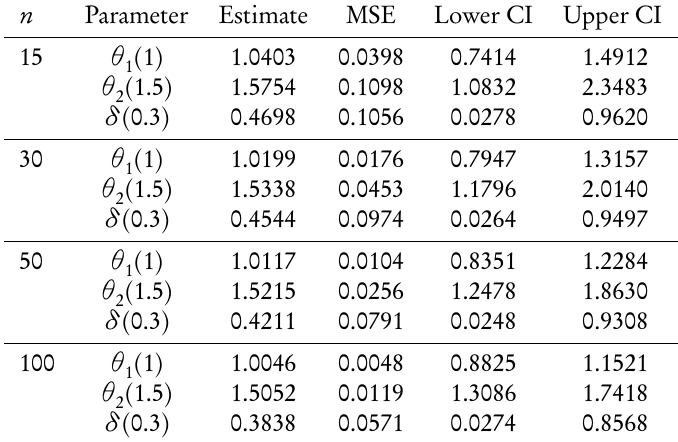
Simulation study of the parameters of BXG distribution (Case 2 - IFM).